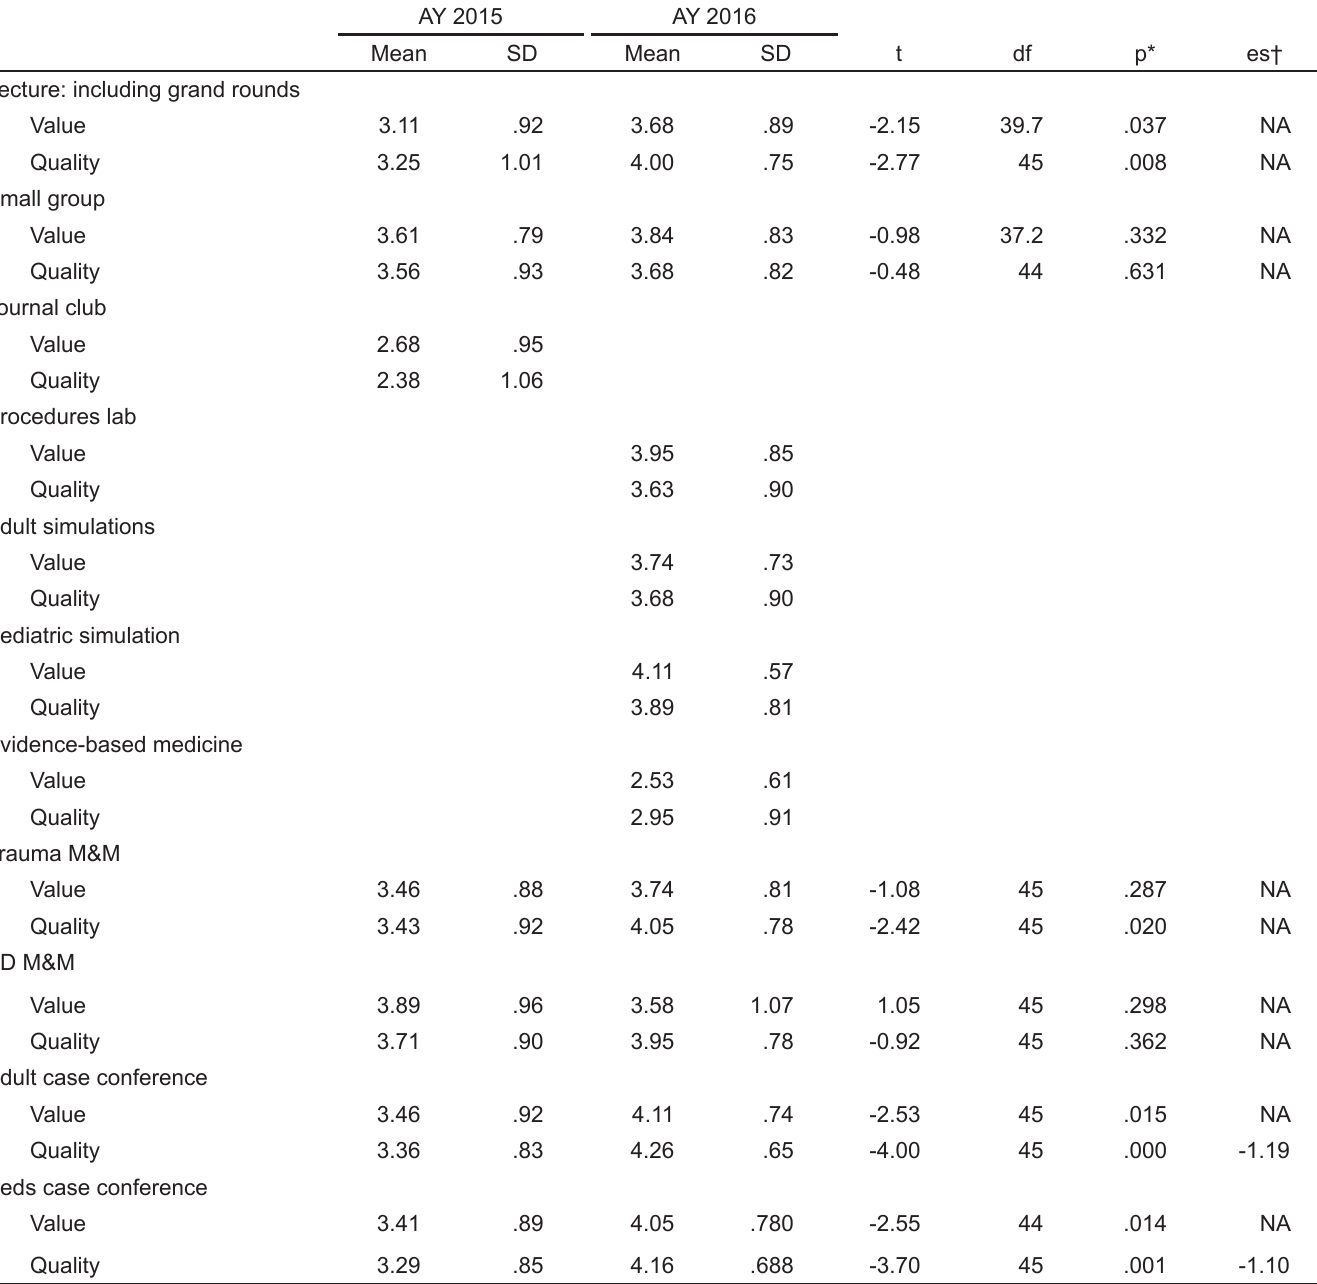
Table 2. Evaluation of program components by 28 of 45 (62.2%) residents from academic year 2015 (lecture curriculum) and 19 of